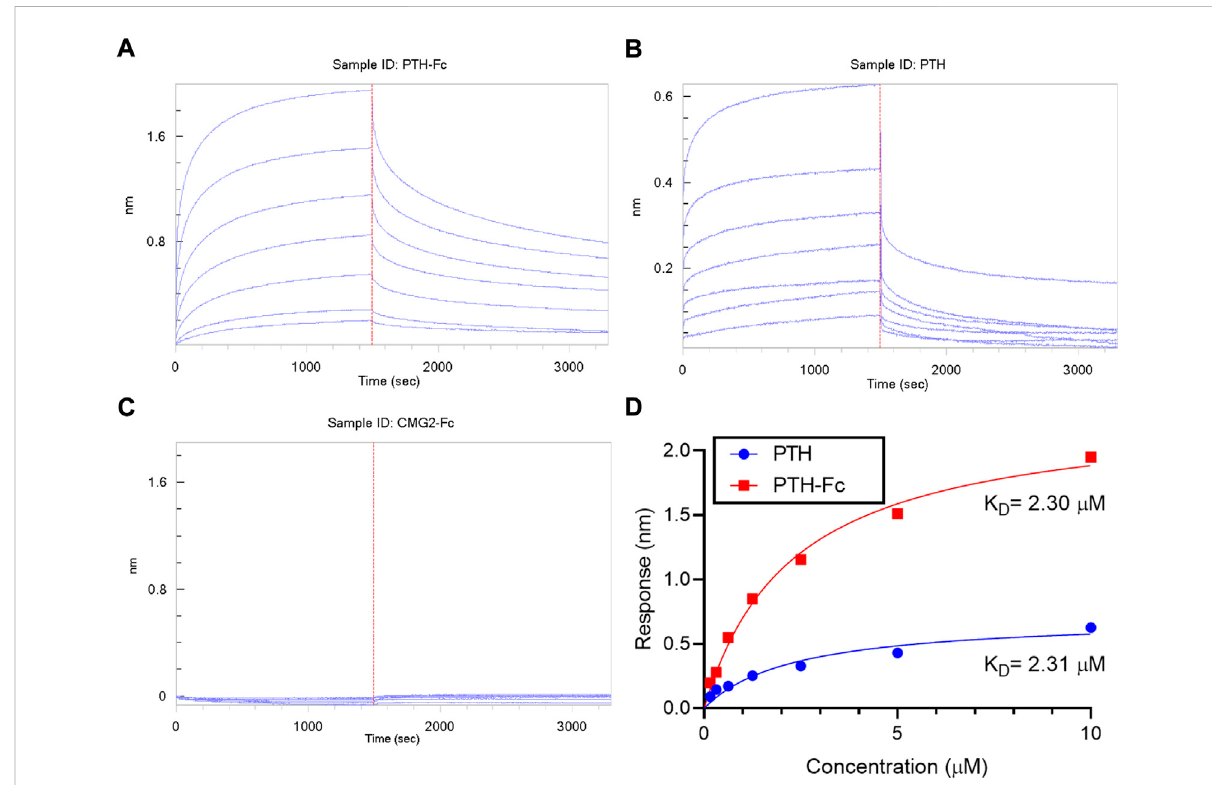
FIGURE 6 BLI sensorgrams (A – C) obtained from interactions between PTH1R and PTH-Fc, PTH or CMG2-Fc; (D) : BLI steady state analysis of receptor binding af fi nity to PTH-Fc (red) and PTH (blue).